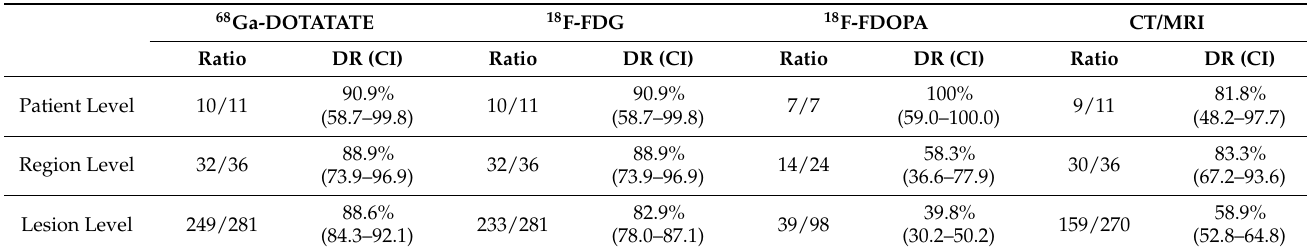
Table 4. Ratios, detection rates (DR), and confidence intervals (CI) of imaging modalities at patient level, lesion level, and region